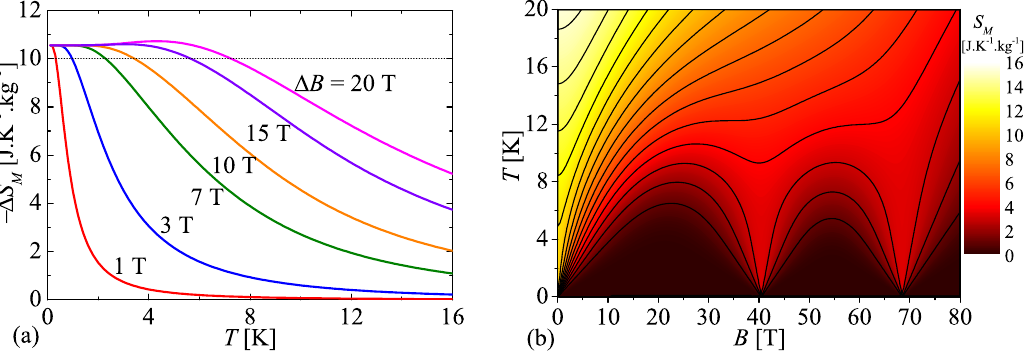
Figure 10. ( a ) temperature variations of the isothermal mass entropy change − ∆ S M of the tetranuclear nickel complex {Ni 4 } for a few selected values of the magnetic-field change. A dotted line, which serves as a guide for eyes only, delimits the parameter space with the enhanced MCE − ∆ S M > 10 J · K − 1 · kg − 1 ; ( b ) a density plot of the magnetic contribution to the mass entropy in the field-temperature plane. Displayed contour lines shed light on adiabatic changes of temperature achieved upon variation of the magnetic field. All results presented in ( a , b ) were calculated for the spin-1 Heisenberg diamond cluster with the coupling constants J 1 / k B = 41.4 K, J 2 / k B = 9.2 K and the gyromagnetic factor g =